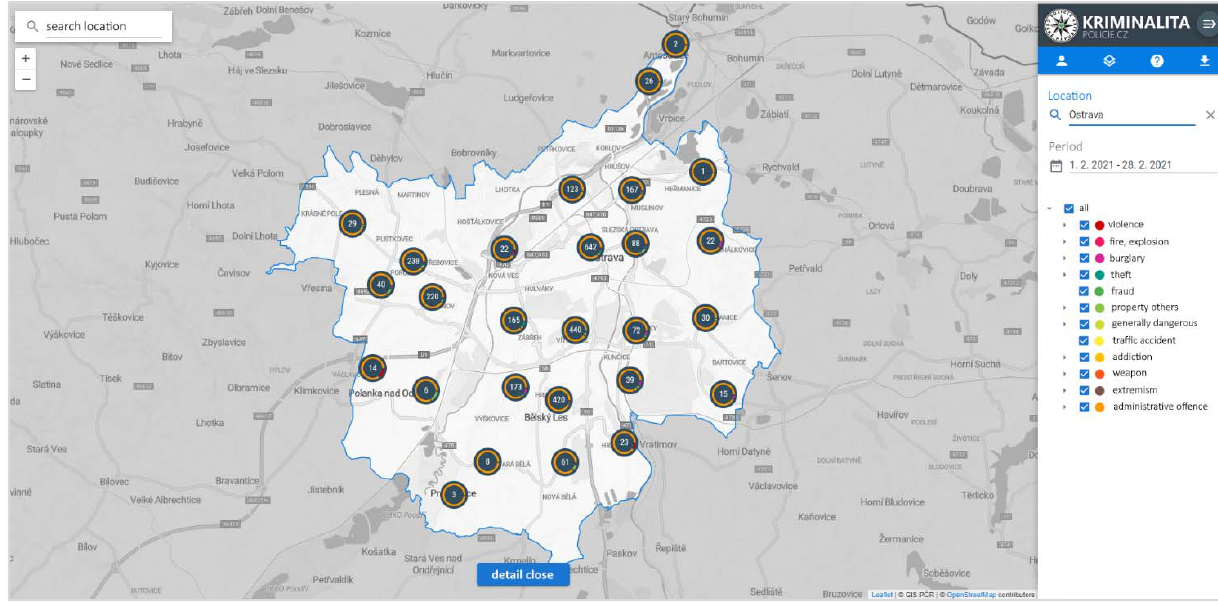
Figure 2. Display of the crime of the Ostrava police district [13]